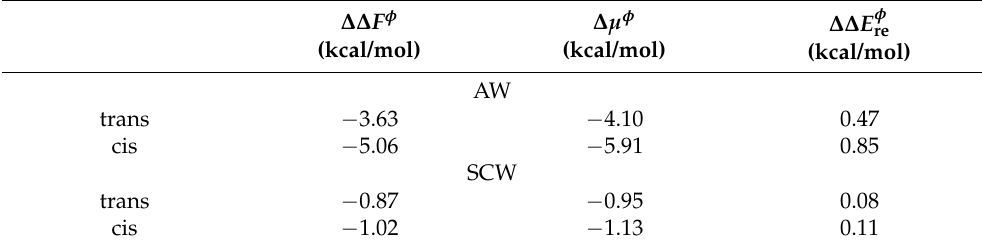
Table 2. Changes in the free energy of the reaction from the gas phase to AW and to SCW. This table is reprinted with permission from JACS , 2000 , 122 , 2289. Copyright 2000 American Chemical